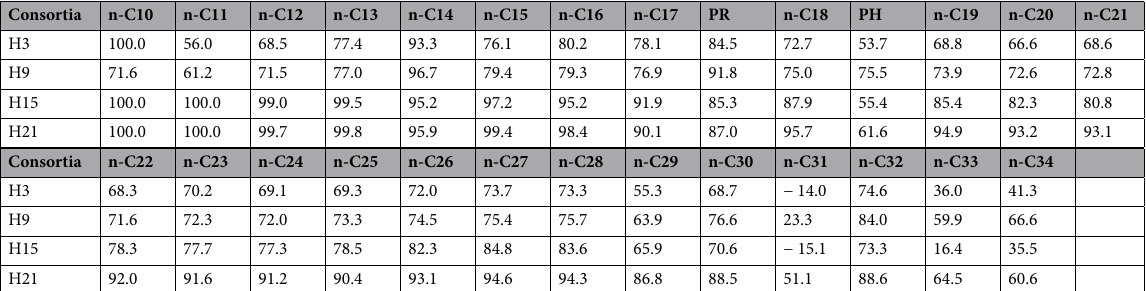
Table 5. The n-alkanes degradation efficiency in the crude oil after biodegrading 3, 9, 15 and 21 days by consortium H. n-Cm: alkane with m carbon atom, for instance, n-C16 is alkane with 16 carbon atom; "PR" is pristane, "PH" is